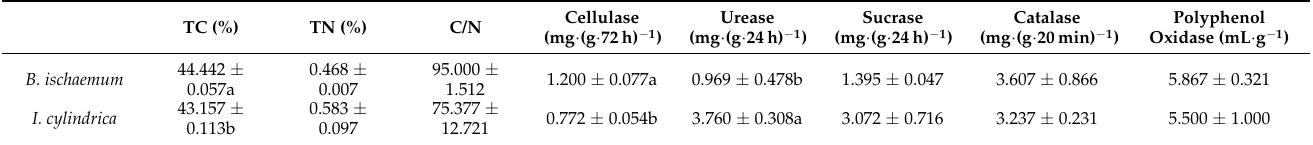
Table 1. Plant litter properties (values denote means with standard